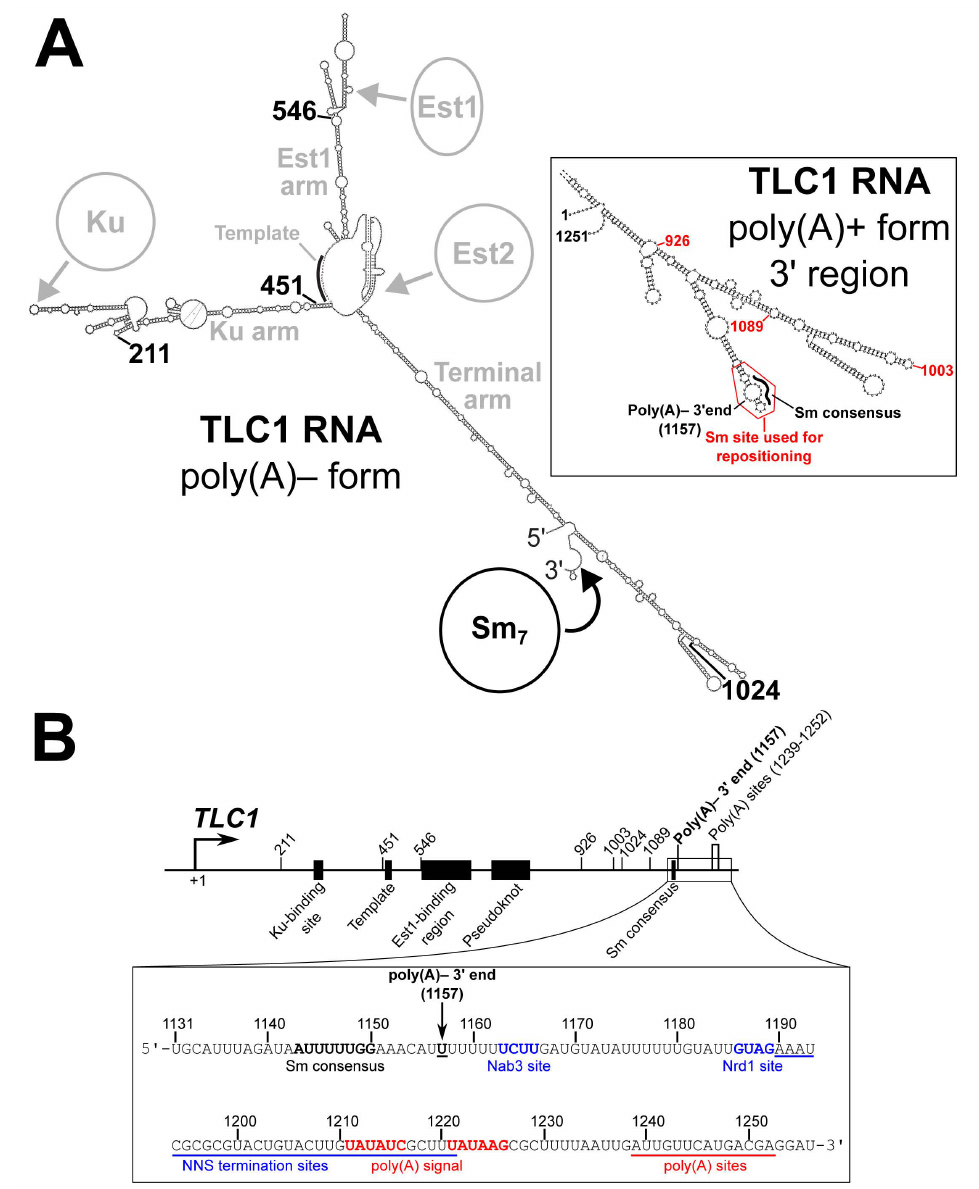
Figure 1. TLC1 sequence schematic and secondary structure models. ( A ) Secondary structure models of the 1157- and 1251-nucleotide (nt) forms of TLC1. The pictured secondary structure of poly(A)– TLC1 is based on previously published models [9,10,18]. The location of Sm binding is indicated